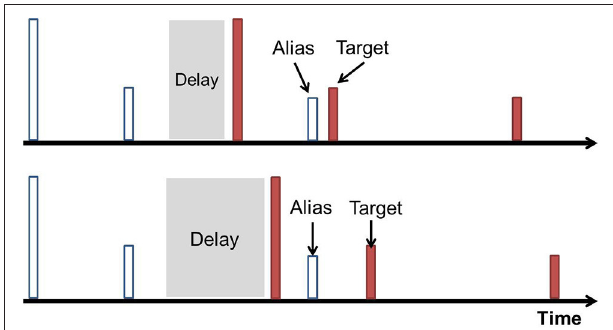
FIGURE 5 | Manipulating the received time of an aliased echo. The tall line represents the pulse and the short lines represent the echoes. The echoes associated with a given pulse are the same color. The top timeline shows an alias (white) that is close to interfering with the first dark echo, the target. The introduced delay is increased (in the bottom timeline) to shift this aliased echo away from the target in time. Similarly, an alias on the other side of the target can also be shifted away by decreasing the delay (not